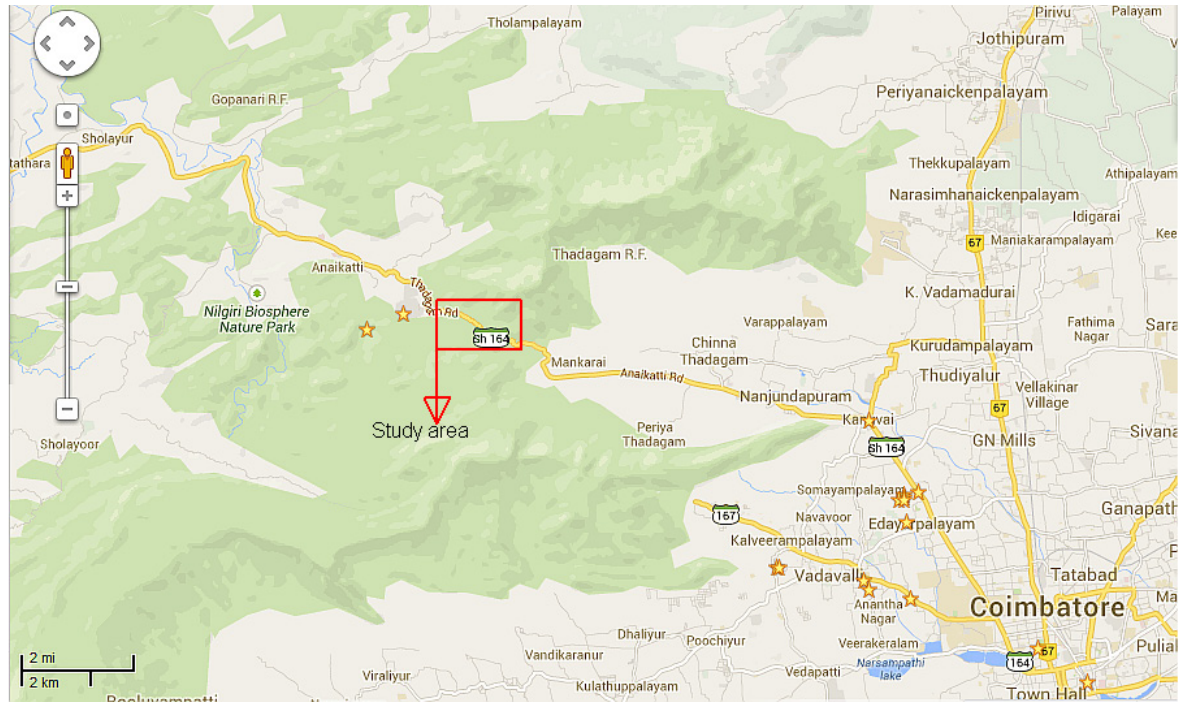
Figure 1. The study area (The road stretch within the red